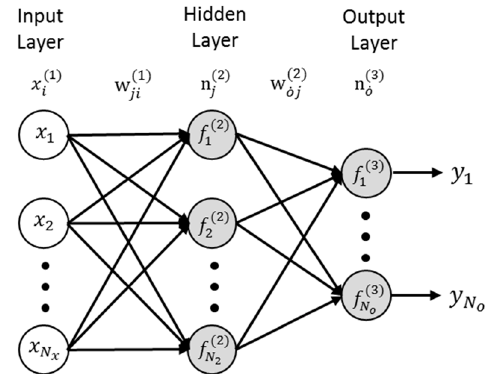
Figure 2. Perceptron with one hidden layer.